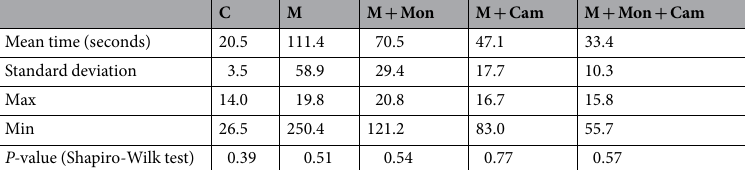
Table 1. The time for completing the task under each condition.